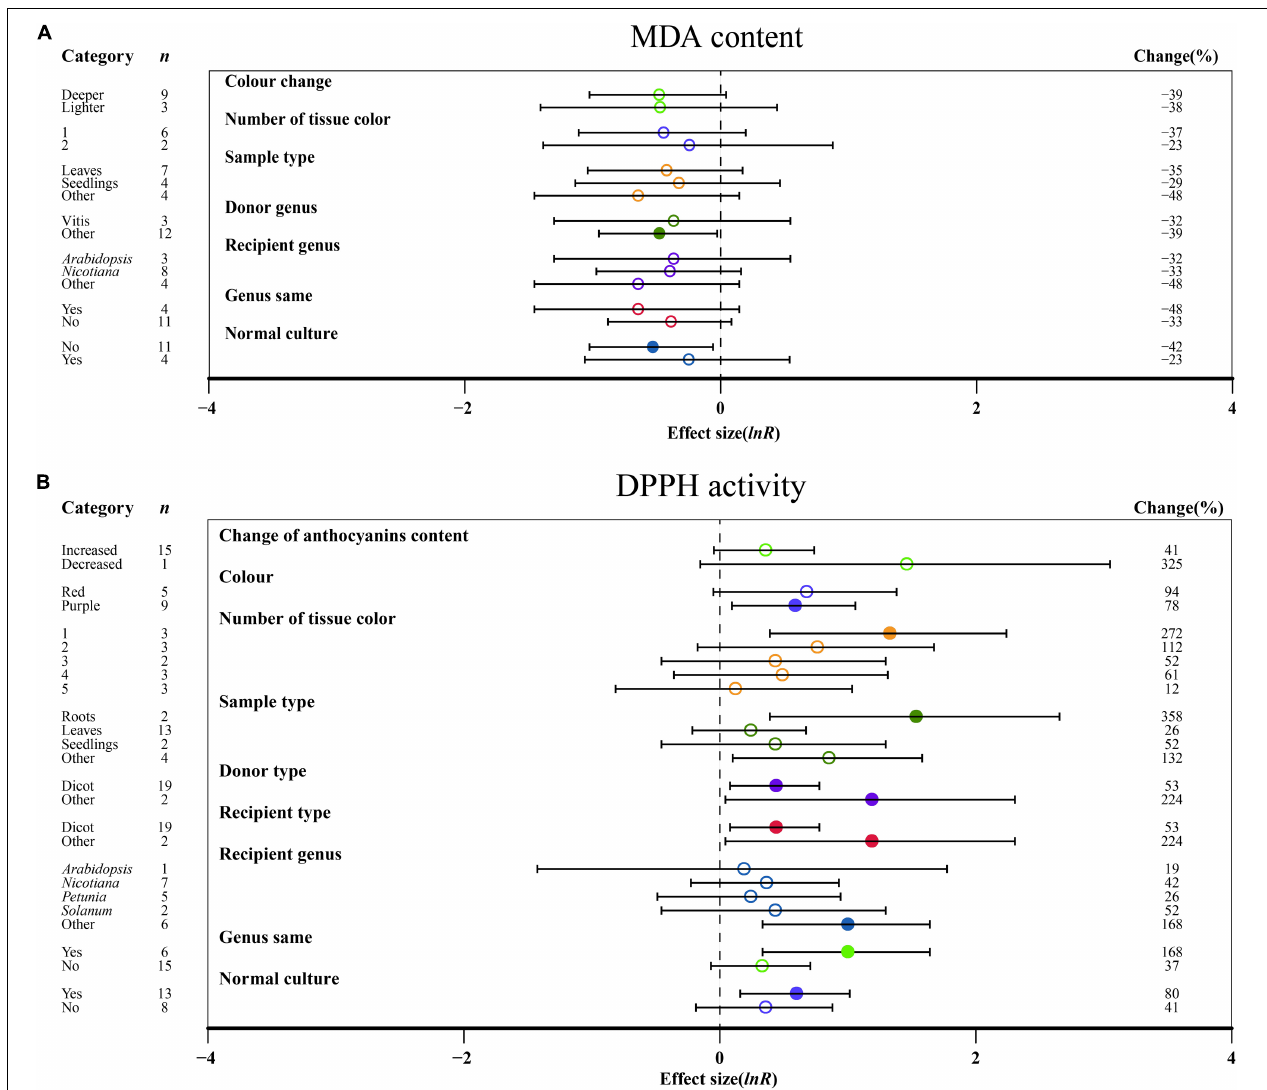
FIGURE 4 | Summary effects (ln R ) of MYB overexpression on MDA content (A) and DDPH activity (B) in plants. Ratios are unit-less. The ratios illustrate the strength of MYB overexpression on the summary effects of MDA content and DDPH activity compared with the controls. Circles and horizontal bars indicate the summary effects and the 95% CI of seven (A) owing to insufficient studies, some moderators not analyzed) and nine (B) owing to insufficient studies, some moderators not analyzed) moderator variables, respectively. n represents the number of studies. Subgroup list levels (subgroups or categories) of each moderator. The percent change (to the right of plots) refers to the raw percentage increase or decrease in MDA content and DDPH activity induced by overexpression of MYB . The moderator variables of the examined plants are colored and distinguished by different colors. Closed and open circles indicate the effects of significance and insignificance,